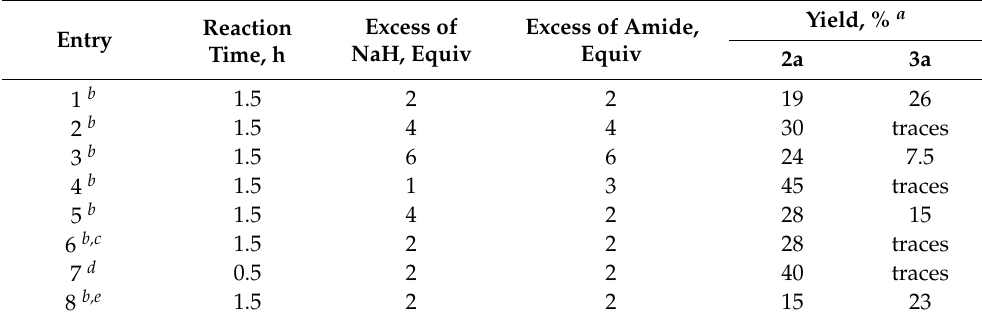
Table 1. Optimization of the Reaction Conditions of S NH Amidation of 5-Nitroisoquinoline ( 1 ) with the p -Methylbenzamide N-anion in anhydrous DMSO (Method A). Reaction Excess of NaH, Entry Time, h Equiv Excess of Amide,